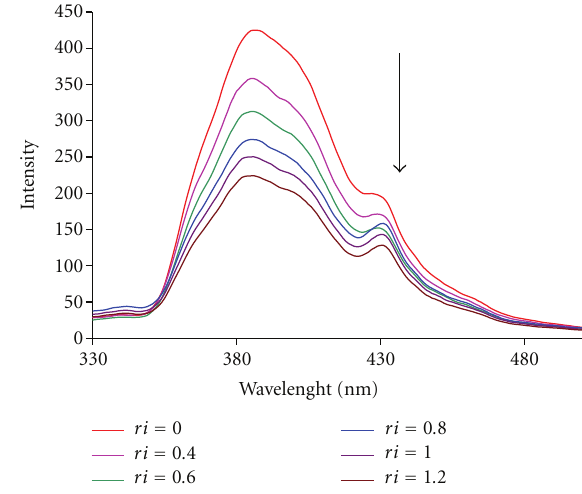
Figure 5: Fluorescence spectra of Pt(II) complex in the presence of various concentrations of CT DNA.